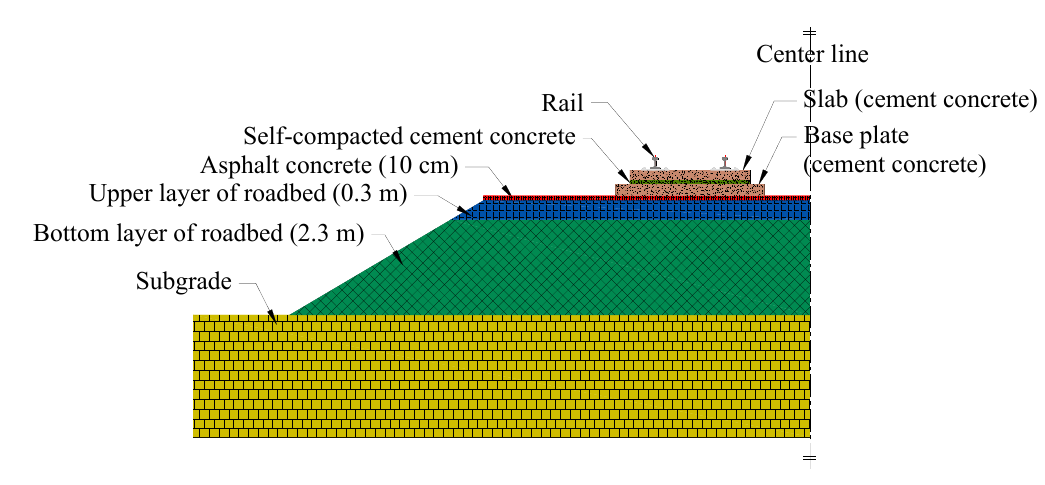
Figure 1. Schematic diagram of the asphalt concrete substructure in the test section.